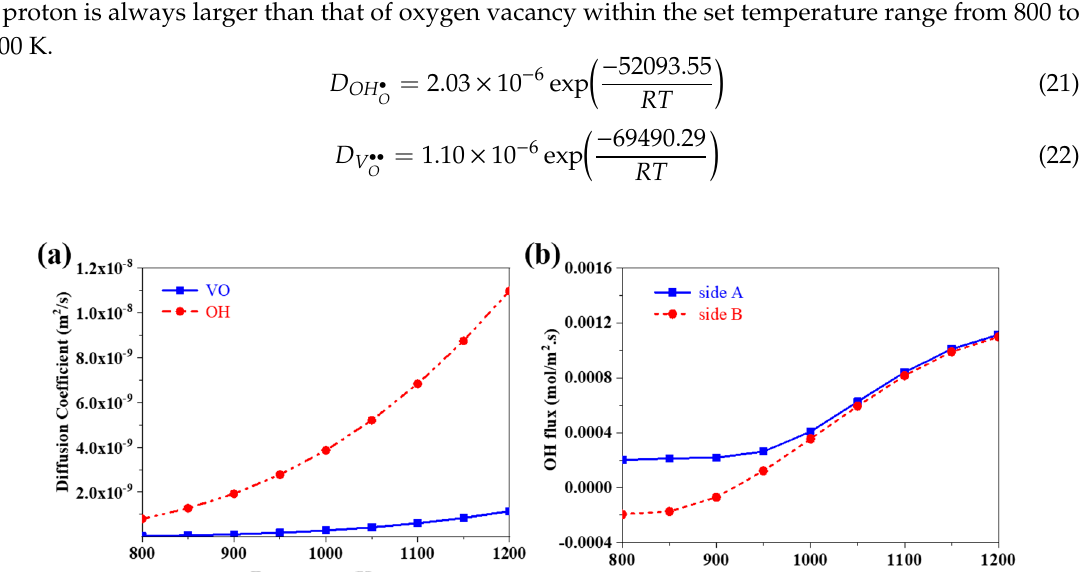
Figure 2. ( a ) The effect of temperature on the diffusion coefficient of proton (OH) and oxygen vacancy (VO); and ( b ) the flux of proton on Sides A and B at different temperatures.